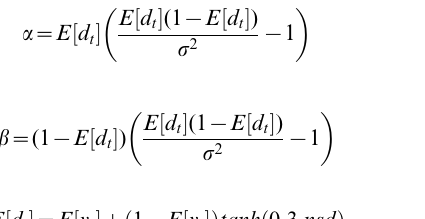
PLoS Computational Biology |